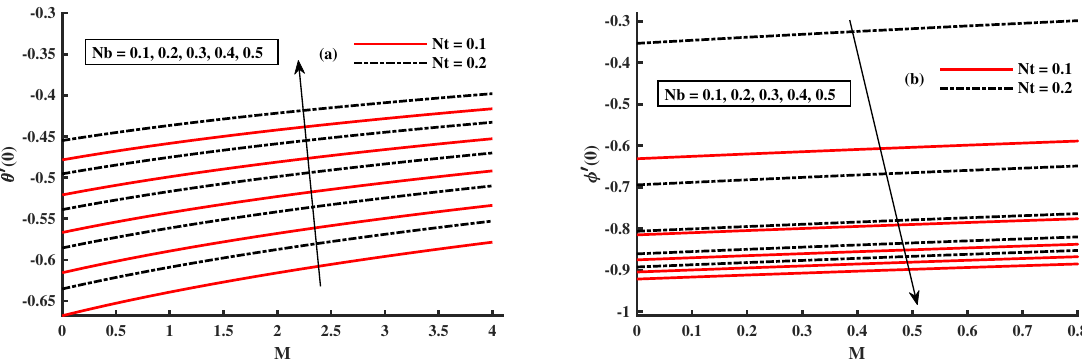
Figure 11. Variation of Nusselt number Nu x and Sheroowd number Sh x along M , Nb and Nt .